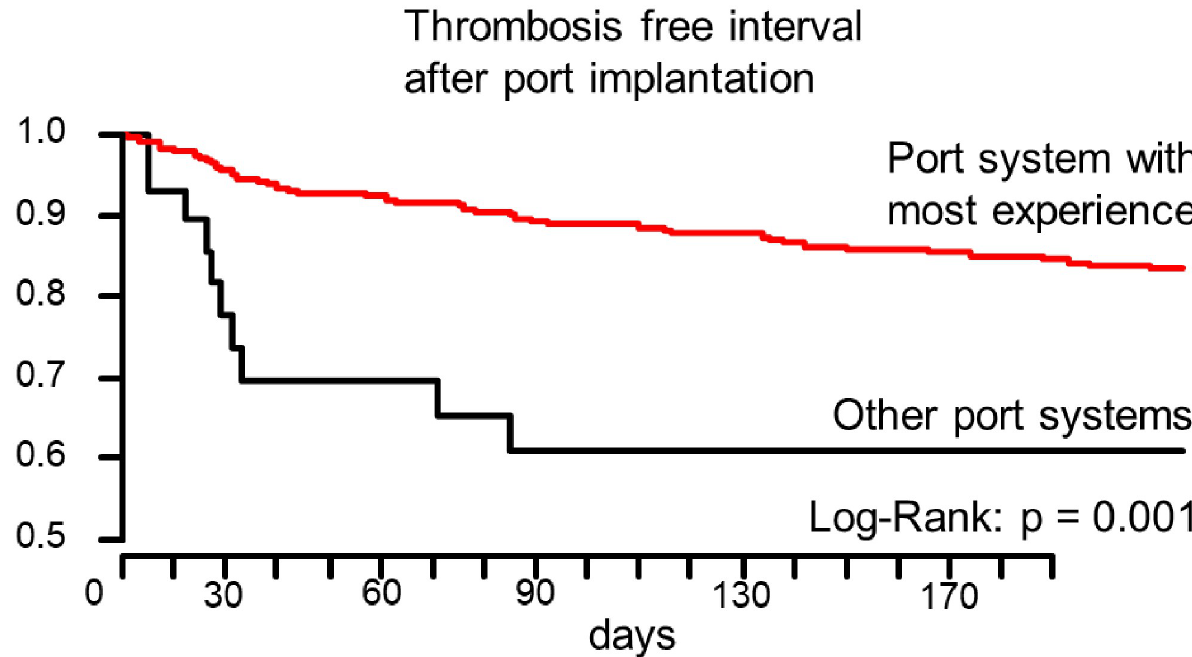
Fig 2. Thrombosis free intervals for the patients with the best-known port system to the team in comparison to other port systems.